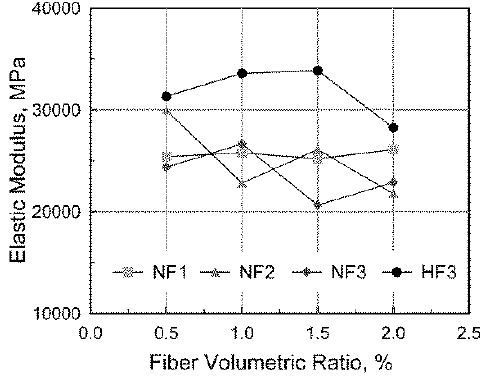
Figure 4. Measured elastic modulus.